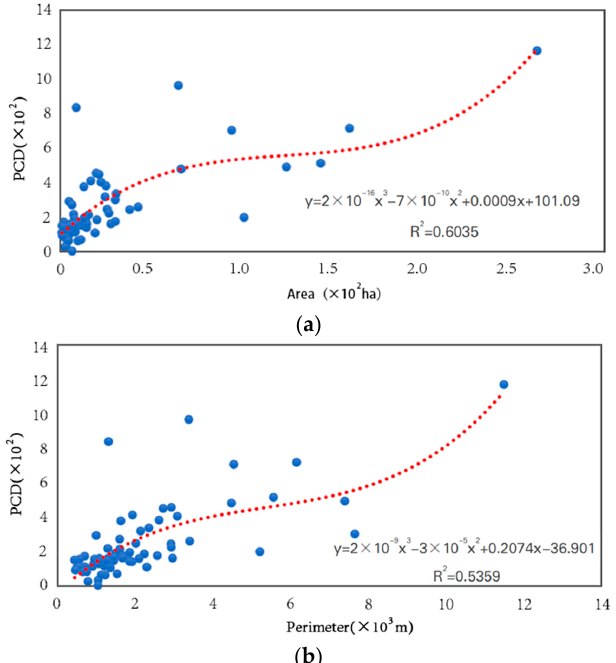
Figure 9. ( a ) Fitted curve of park cooling distance and park area; ( b ) fitted curve of park cooling distance and